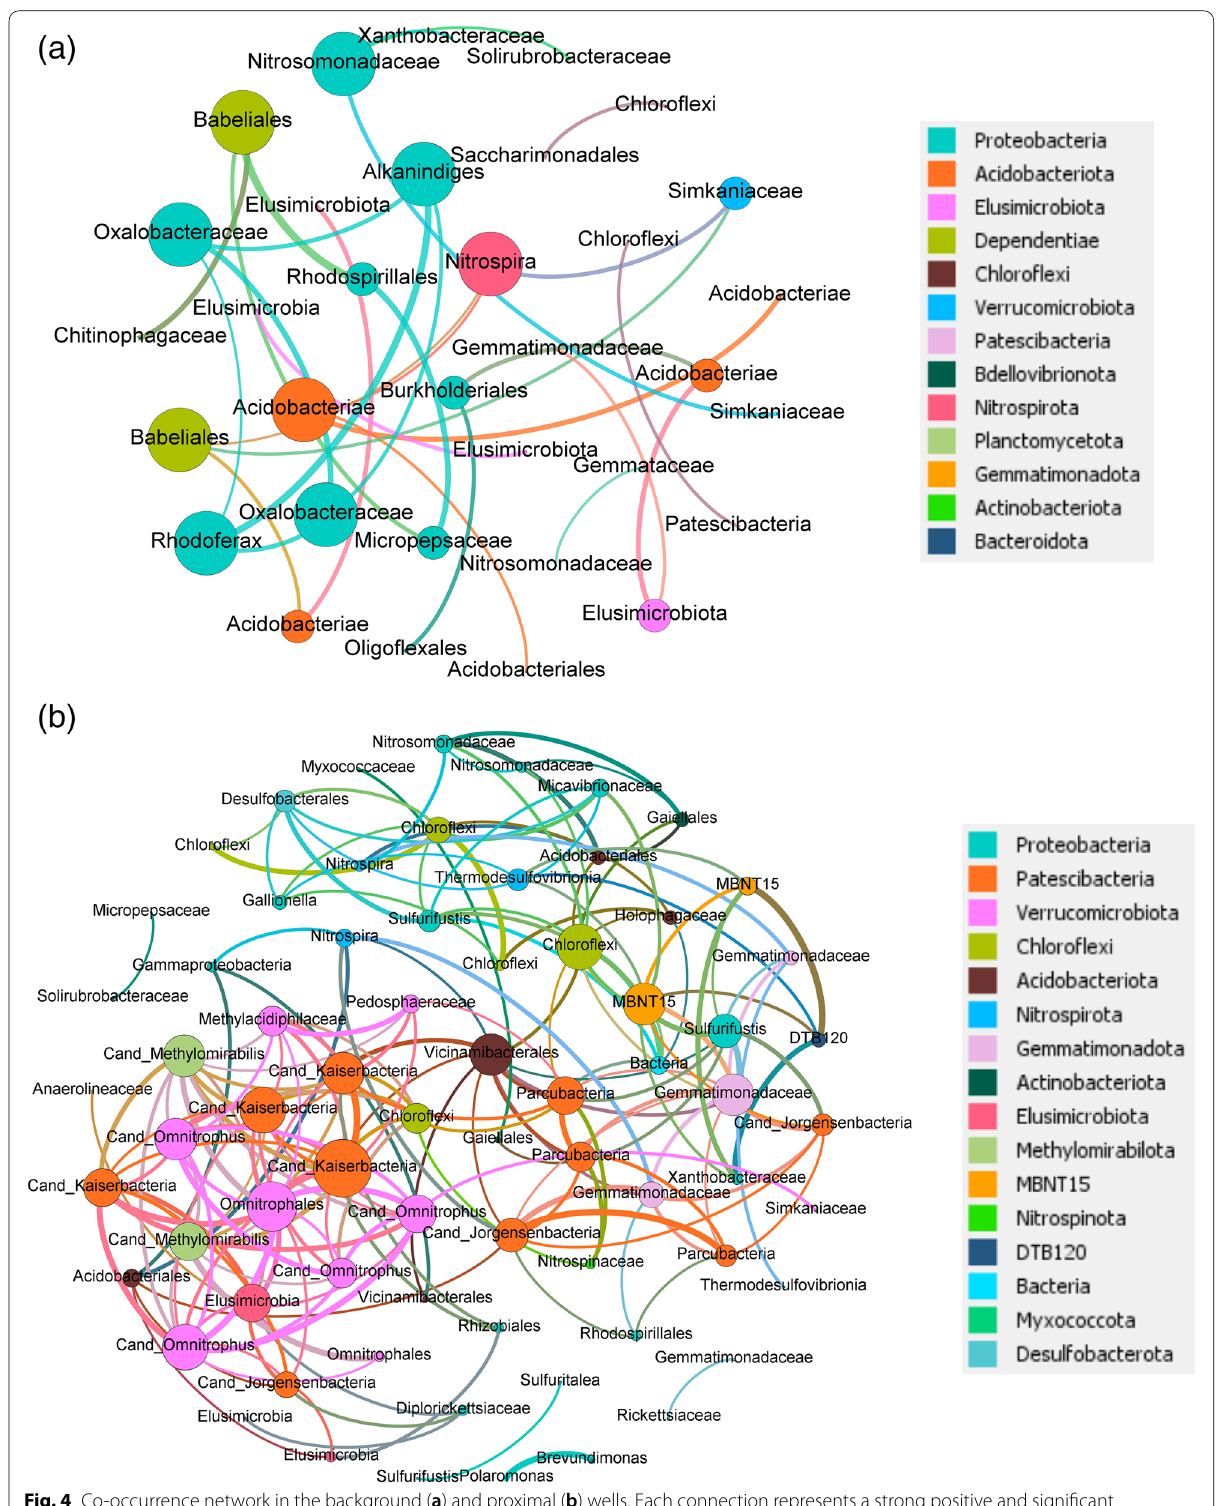
Fig. 4 Co-occurrence network in the background ( a ) and proximal ( b ) wells. Each connection represents a strong positive and significant Spearman’s correlation (ρ > 0.6, P < 0.01) and the thickness of the connections is proportional to the correlation coefficient. The size of the nodes is proportional to the node degree (number of connections), and the node colours represent microbial